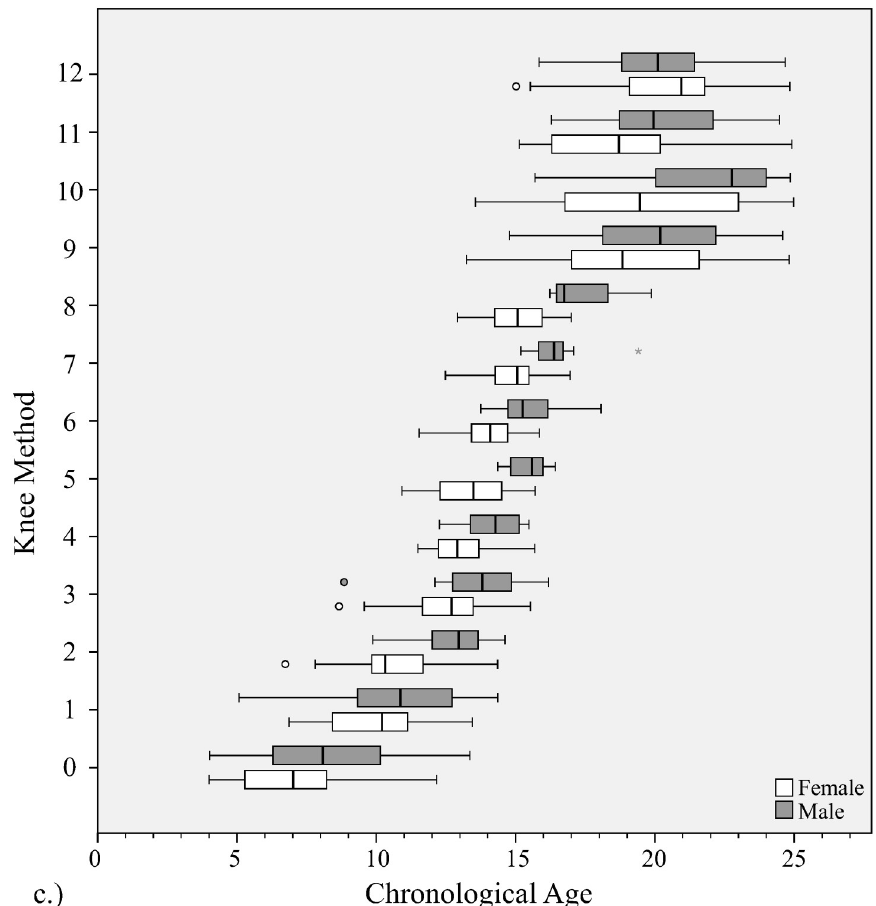
Fig 5. Distribution of chronological ages at each bone age stage with knee method. Gender is shown at each stage.